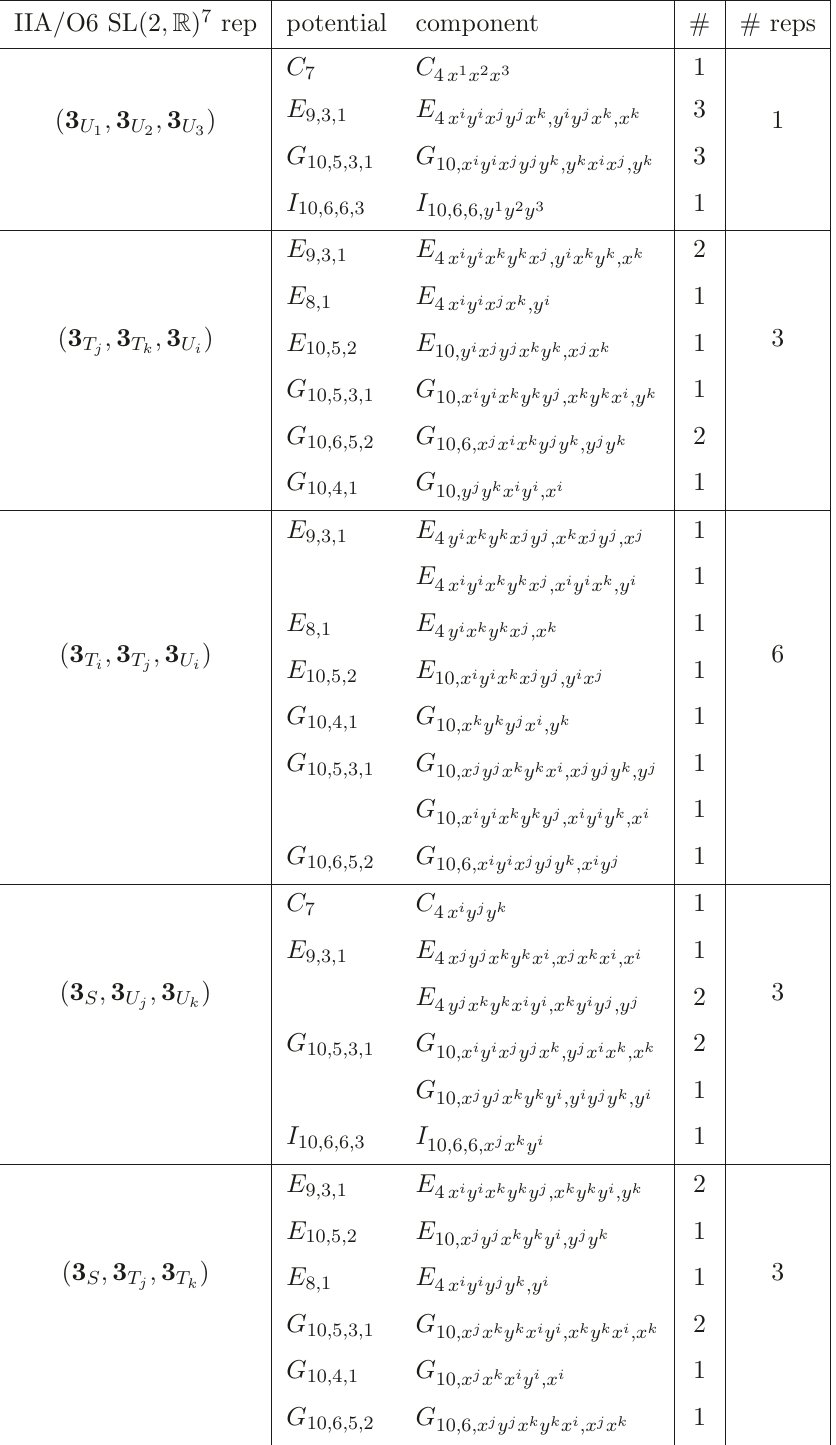
Table 9 . The SL(2 , R ) 7 representations of the IIA/O6 potentials which couple to the allowed space- filling branes, which have α odd. They are all the possible representations with four singlets and three triplets of SL(2 , R ) | T . The branes are 2 7 in number and organise in 16 different representations.